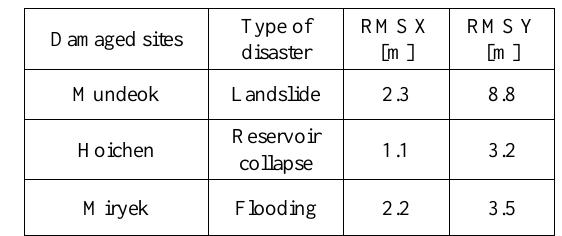
Table 4. Geo-corrction accuracy small drone mapping